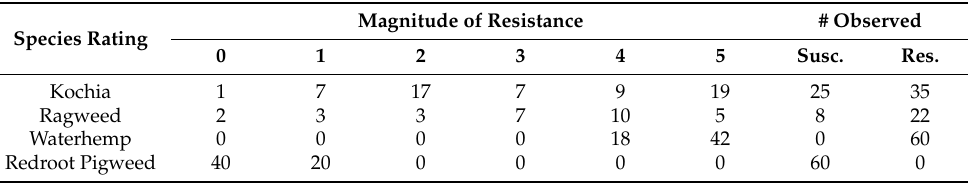
Table 4. Carrington Plant Survival Evaluation at 14 DAA.